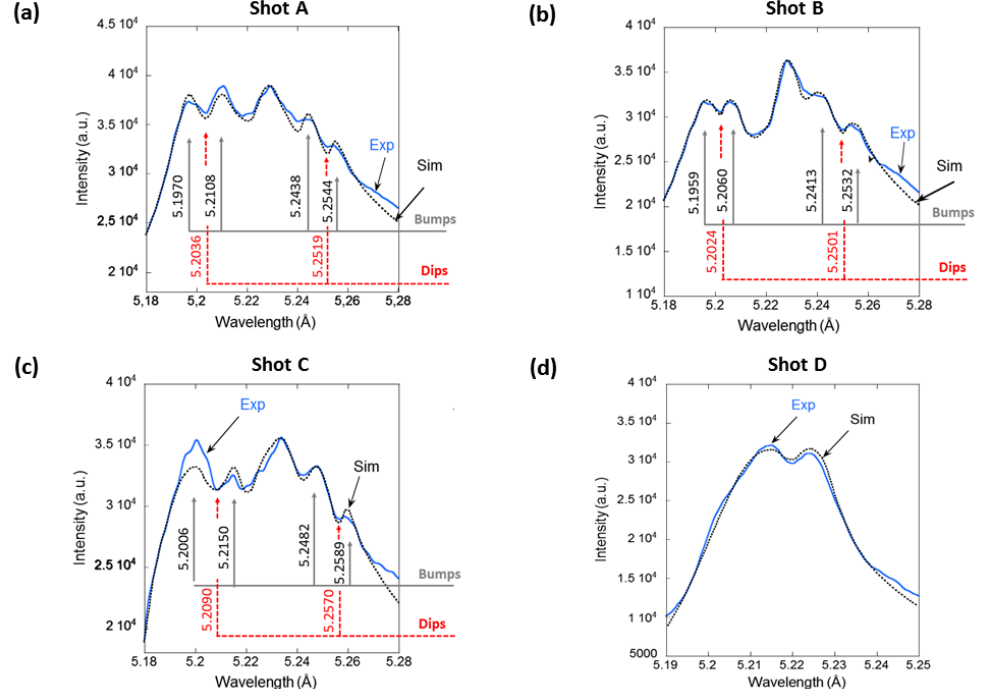
Figure 5. Comparison of the experimental profiles of the Si XIV Ly-beta line (solid line, blue in the online version, marked Exp) with the theoretical profiles (dotted line, black, marked Sim) allowing for the effects of the Langmuir waves, the LET, and all other broadening mechanisms (see the text). In the profiles from shots A, B, and C, there are clearly seen ‘bump–dip–bump’ structures (both in the red and blue parts of the profiles) typical for the L-dips phenomenon. The L-dips are not observed in shot D. The following parameters provided the best fit: ( a ) N e = 2.2 × 10 22 cm −3 , T = 600 eV, F t,rms = 4.8 GV/cm, E 0 = 0.7 GV/cm; ( b ) N e = 2.2 × 10 22 cm −3 , T = 550 eV, F t,rms = 4.4 GV/cm, E 0 = 0.5 GV/cm; ( c ) N e = 2.2 × 10 22 cm −3 , T = 600 eV, F t,rms = 4.9 GV/cm, E 0 = 0.6 GV/cm; ( d ) N e = 6.6 × 10 21 cm −3 , T = 550 eV, F t,rms = 2.0 GV/cm, E 0 = 2.0 GV/cm [13].